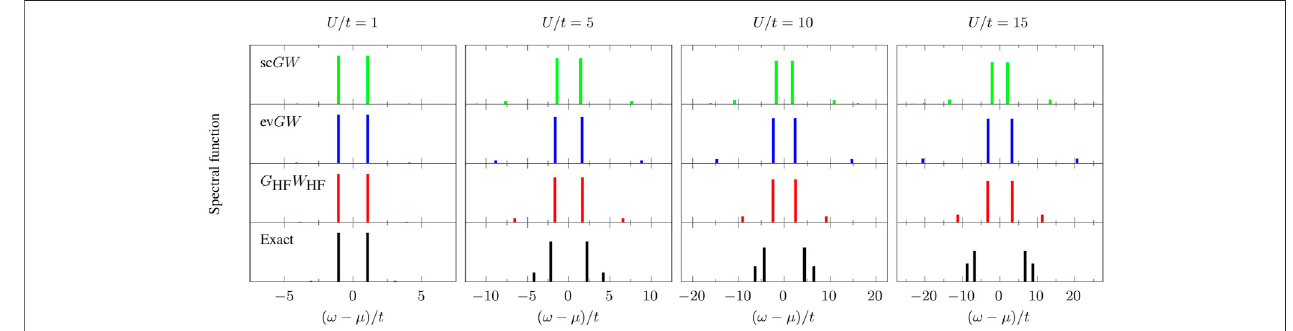
FIGURE 2 | Fundamental gap ( E g ), quasiparticle weight factors ( Z QP bn/an ), and ground state energy ( E 0 ) as functions of U / t obtained from one-shot GW (dashed red line), ev GW (dashed-dotted blue line), sc GW (dotted green line) using G HF (left) or G 0 (right) as starting point. The black curves are the exact results.